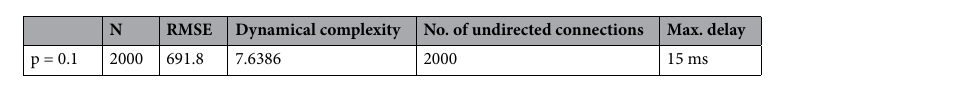
Table 3. Undirected